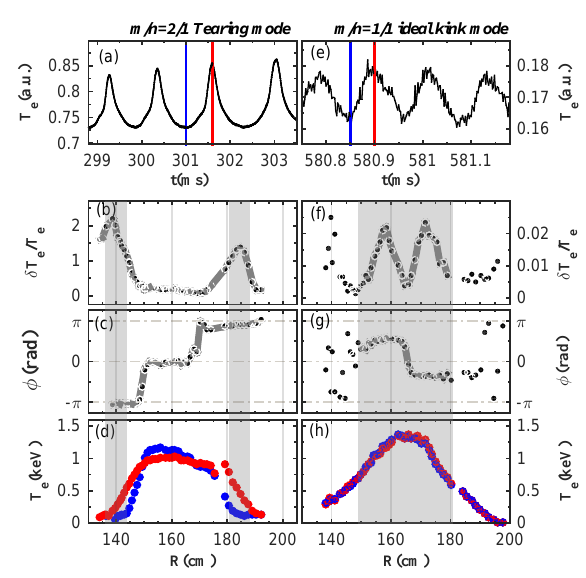
Figure 6. (a) time evolution of T e inside but near the q = 2 surface, (b-c) the amplitude and phase of the relative T e variation δ T e / ¯ T e with an m / n = 2 / 1 tearing mode, (d) T e profiles at two moments (O- / X-point passing-by) marked by the blue and red vertical lines in (a), (e) time evolution of T e near the q = 1 surface, (f-g) the amplitude and phase of the relative T e variation δ T e / ¯ T e with an m / n = 1 / 1 ideal kink mode, and (h) T e profiles at two moments marked by the blue and red vertical lines in (e). The locations of the mode were shaded in the